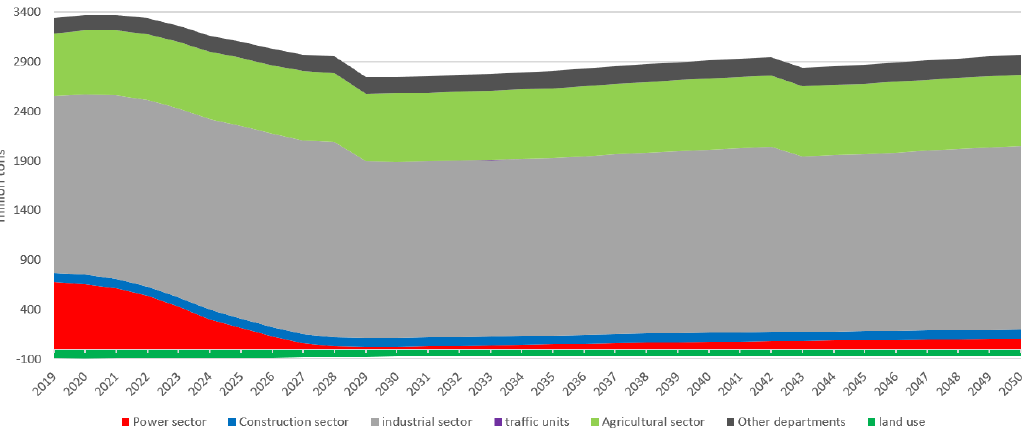
Figure 11. Change of carbon dioxide emissions in Inner Mongolia under carbon pricing scenario.